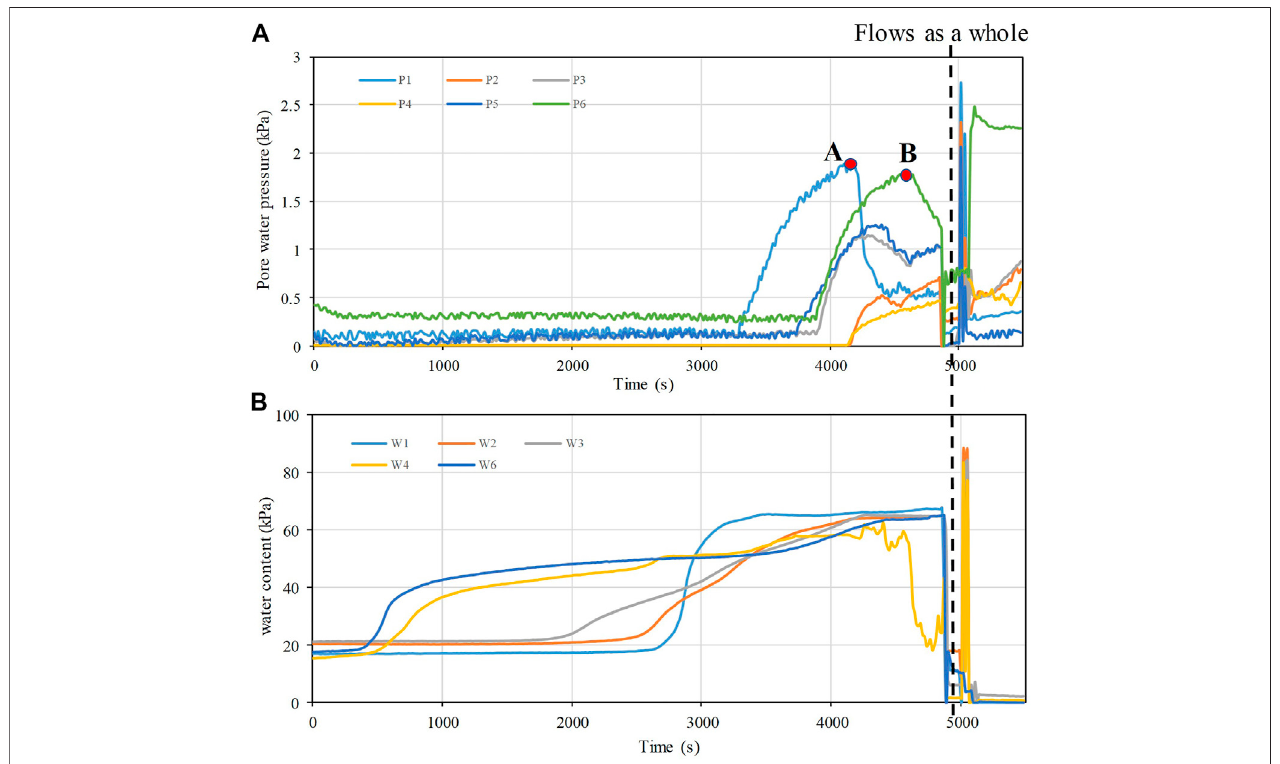
FIGURE 5 | Variations in pore water pressure and water content with time in the fl ume test with a slope angle of 13 ° . (A) Pore water pressure; (B) Water content. Small-scale mud fl ow and retrogressive toe sliding.